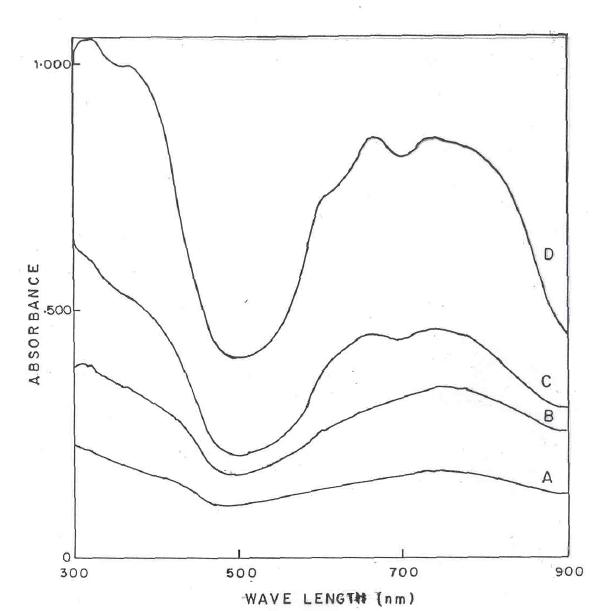
SO (A) Pure PANI (B) PANI 2 4